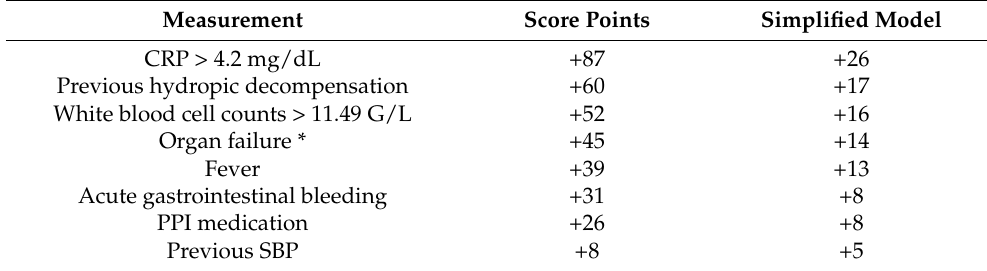
Table 1. Lasso Score model. The main score and simplified score model to differentiate SBP/SecP from non-infected ascites in patients with hydropic decompensated liver cirrhosis. The probability of infected ascites increases with every score point. The ideal cut-off values of the main score model and the simplified score are >72 and >23.